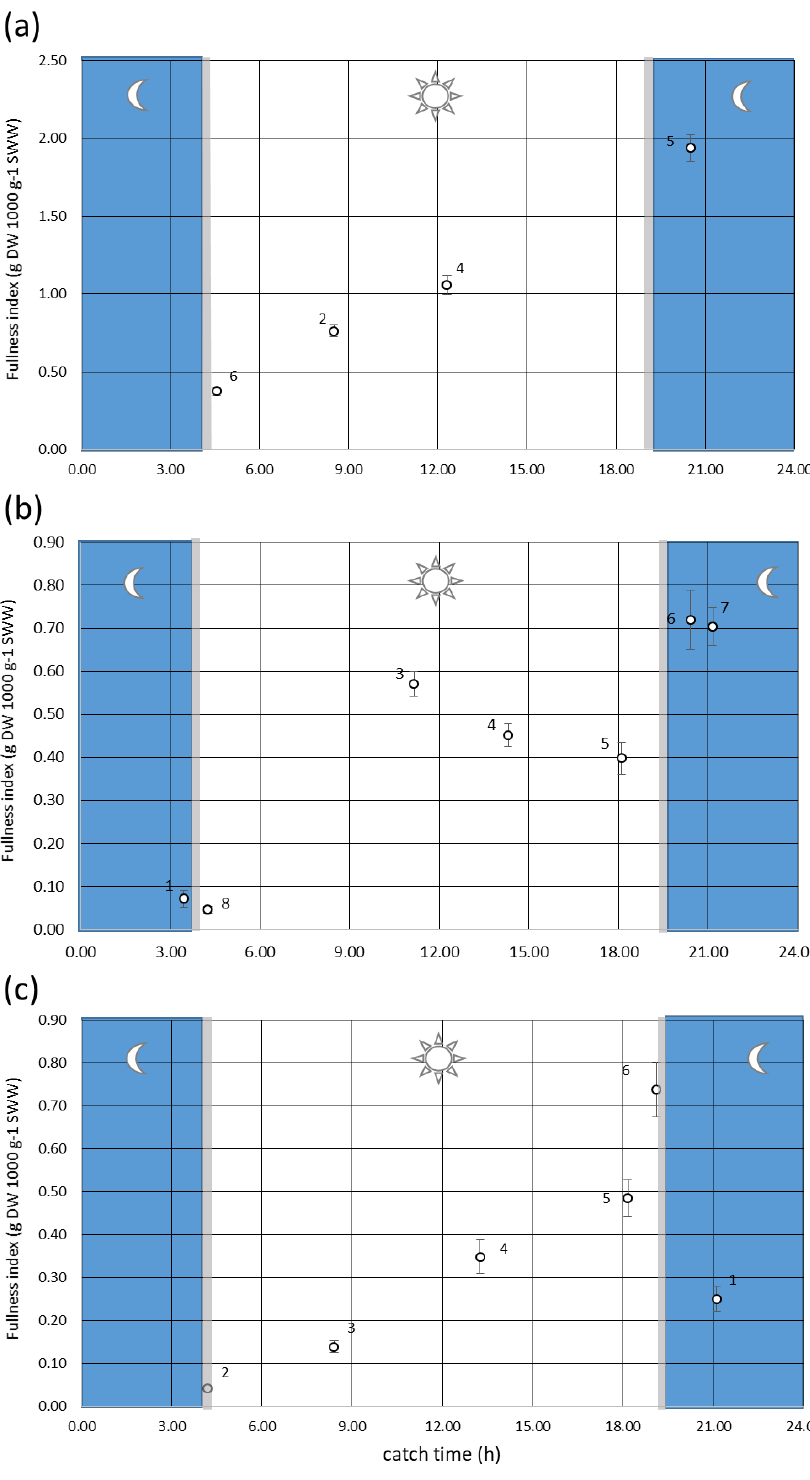
Figure 4. Sampling time vs. Fullness index, where numbers refer to the tow number, bars to the standard error and grey shaded line to the sunrise and sunset: ( a ) May; ( b ) June; ( c ) July 2006. Copepods were the most abundant food category in the stomachs of captured sar- dines in all months, with the sole exception of June when tintinnids predominated numer- ically. Among copepods, the Clauso-Paracalanidae group and the genus Oncaea were by far the most important, alternately dominating. Copepod nauplii were always found, with